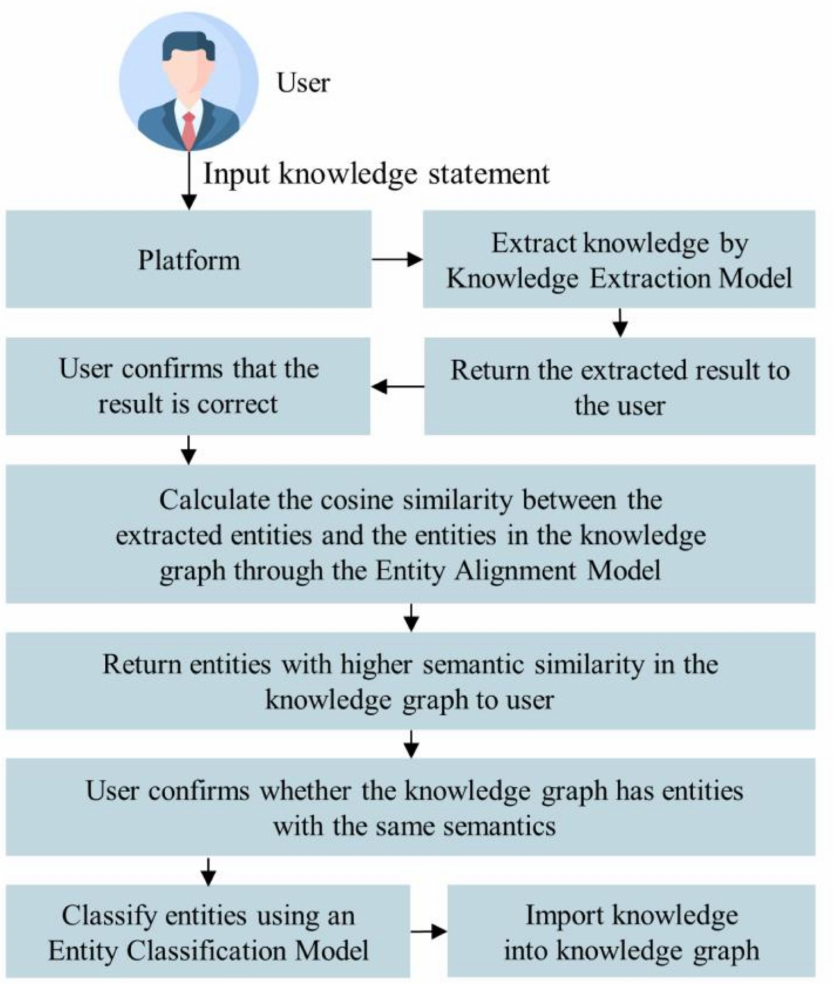
Figure 6. Process flow diagram of importing knowledge into a knowledge